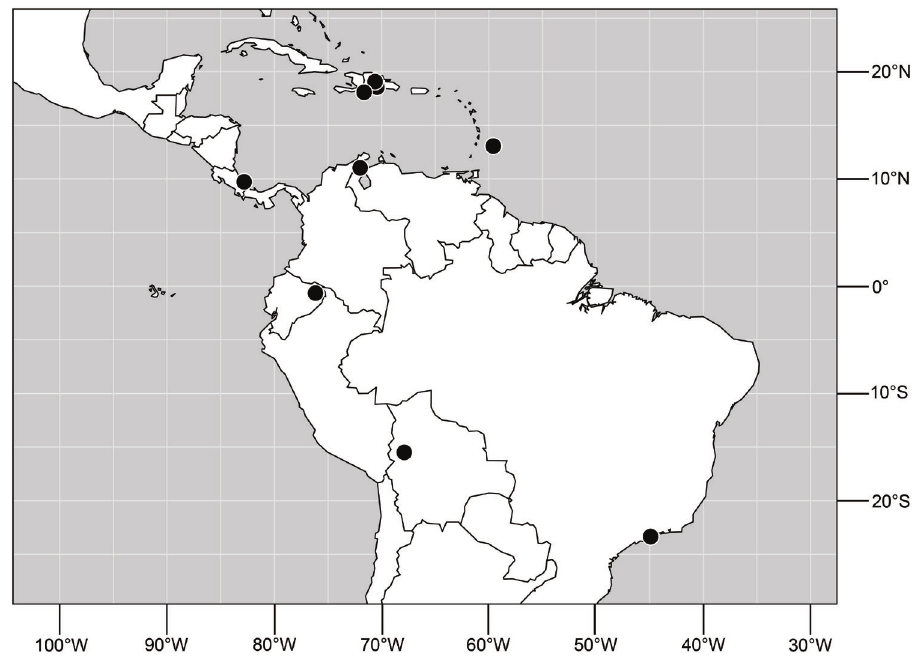
Figure 90. Distribution of Hydrochasma glochium sp.